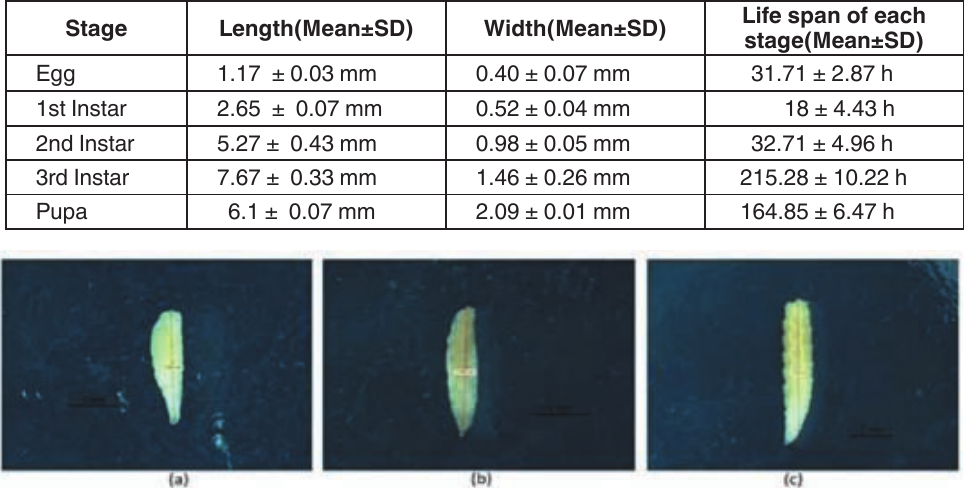
table 2. Length, width and duration of different life stages of H. ligurriens in natural conditions in Kerala, India